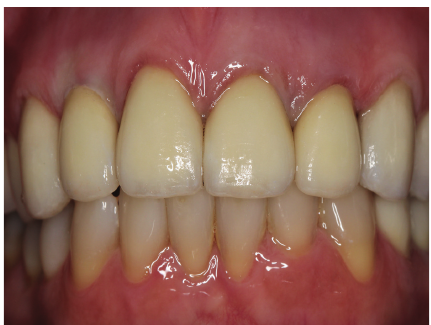
Figure 10: Surface etching with 10% hydrofluoric acid gel.